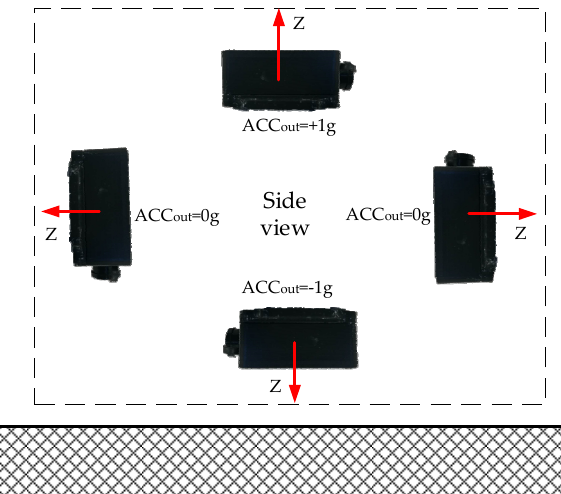
be multiplied by the calculation coefficient and the intercept is subtracted to obtain the acceleration value.